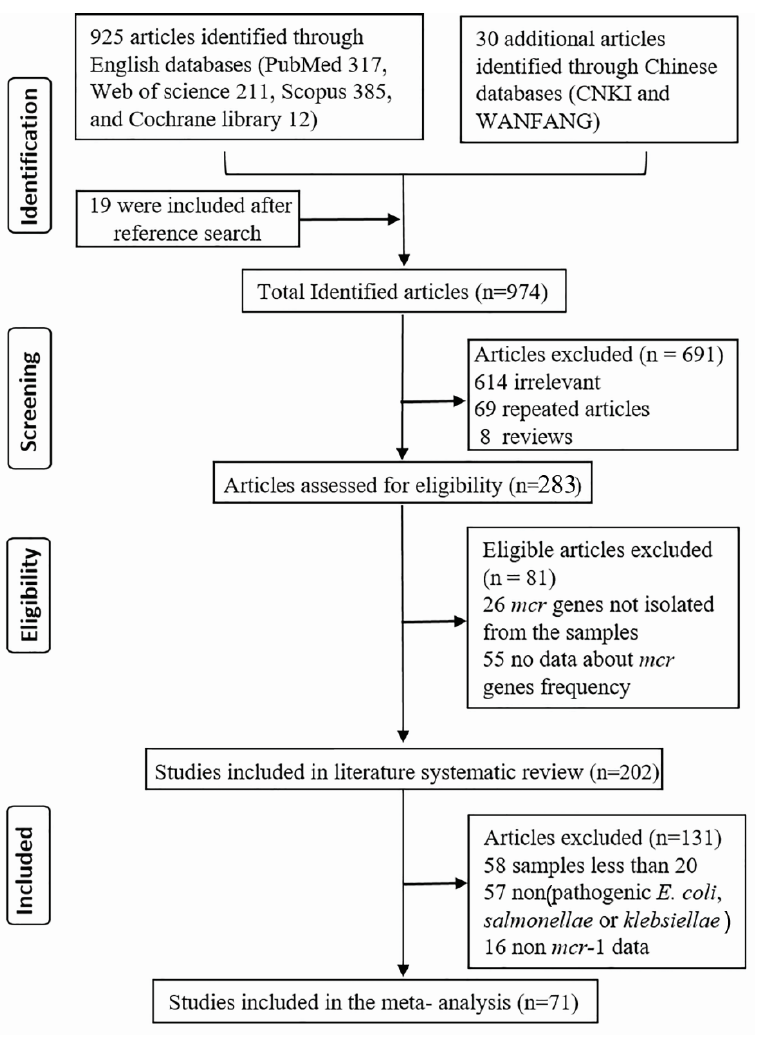
Figure 1. Flow diagram of identification and selection process included in systematic review and meta-analysis .